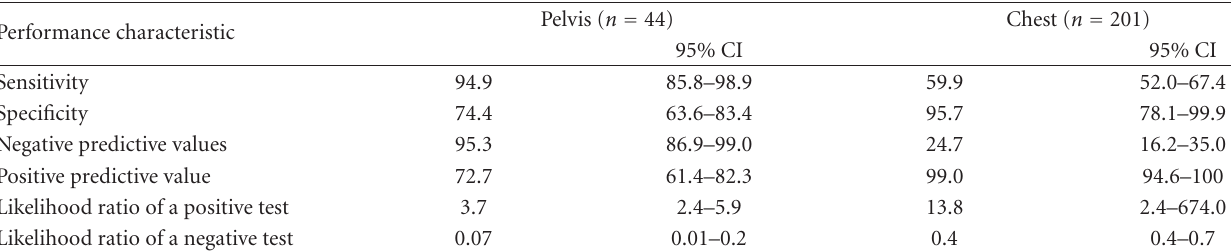
Table 3: Performance characteristics of plain films compared to